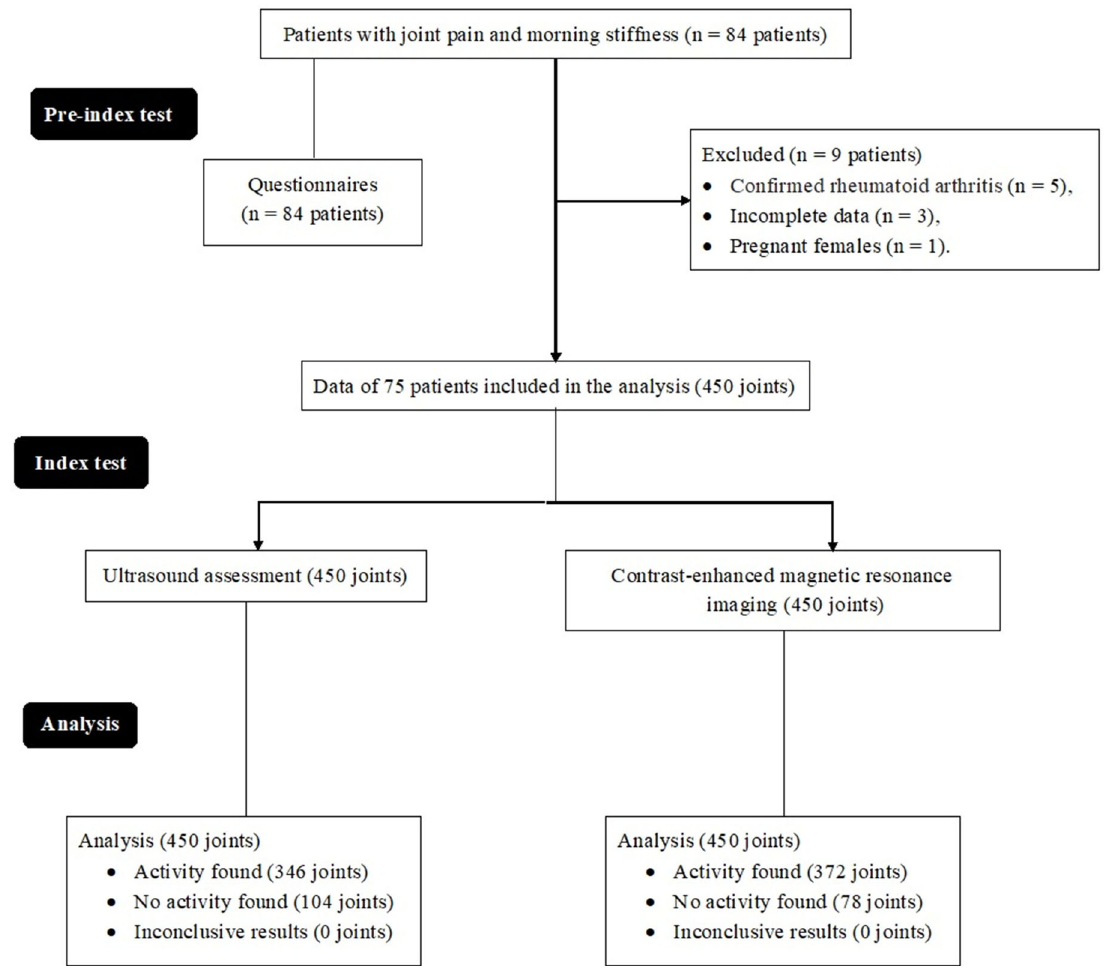
Figure 1 - Flow diagram of the analysis.